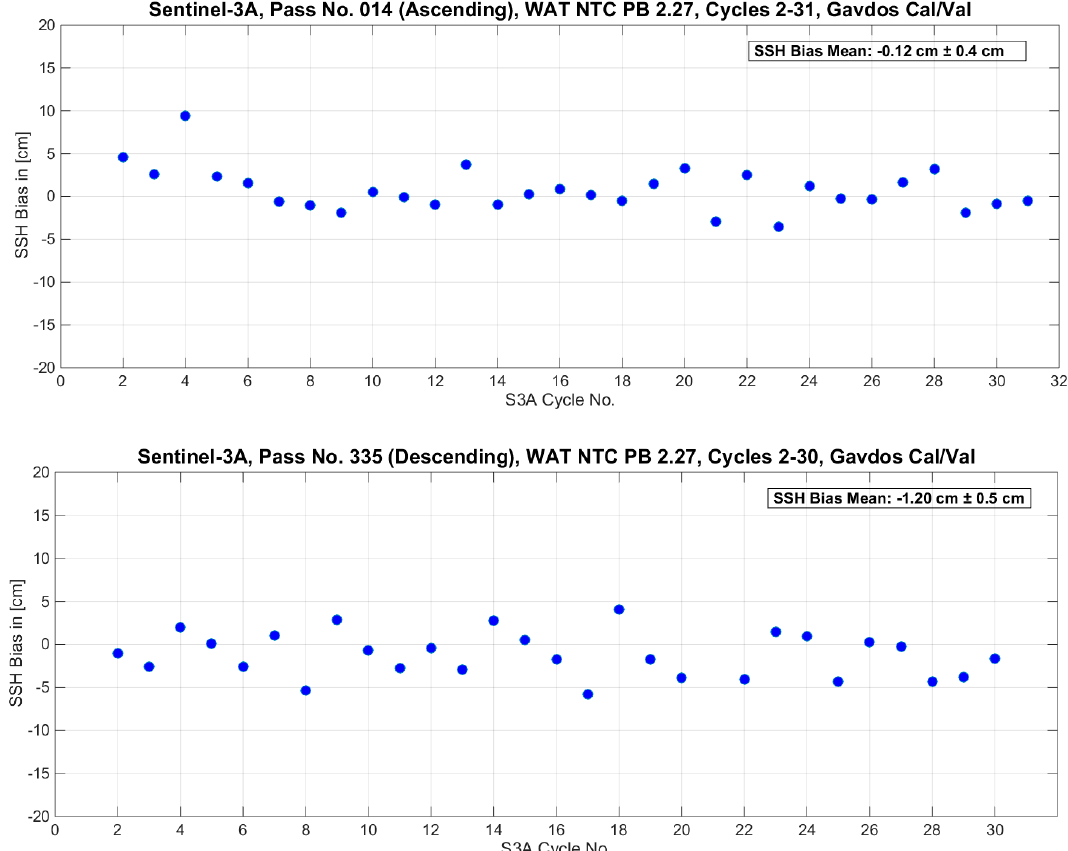
Figure 20. Sea-surface height biases for the ascending Pass No.14 ( up ) and descending ( down ) Pass No.335 of Sentinel-3A, as estimated by the Gavdos Cal/Val site.